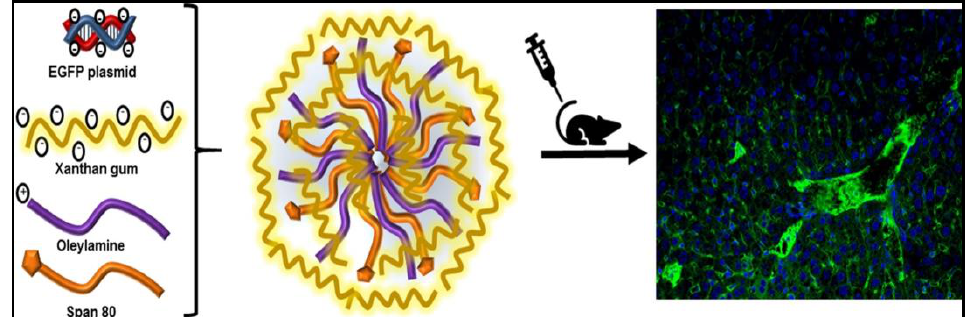
Figure 5. Xanthan gum-based span nanoparticles for gene delivery to endothelial cells [113]. Repro- duced with permission from ref [113]. Copyright 2018 Elsevier.